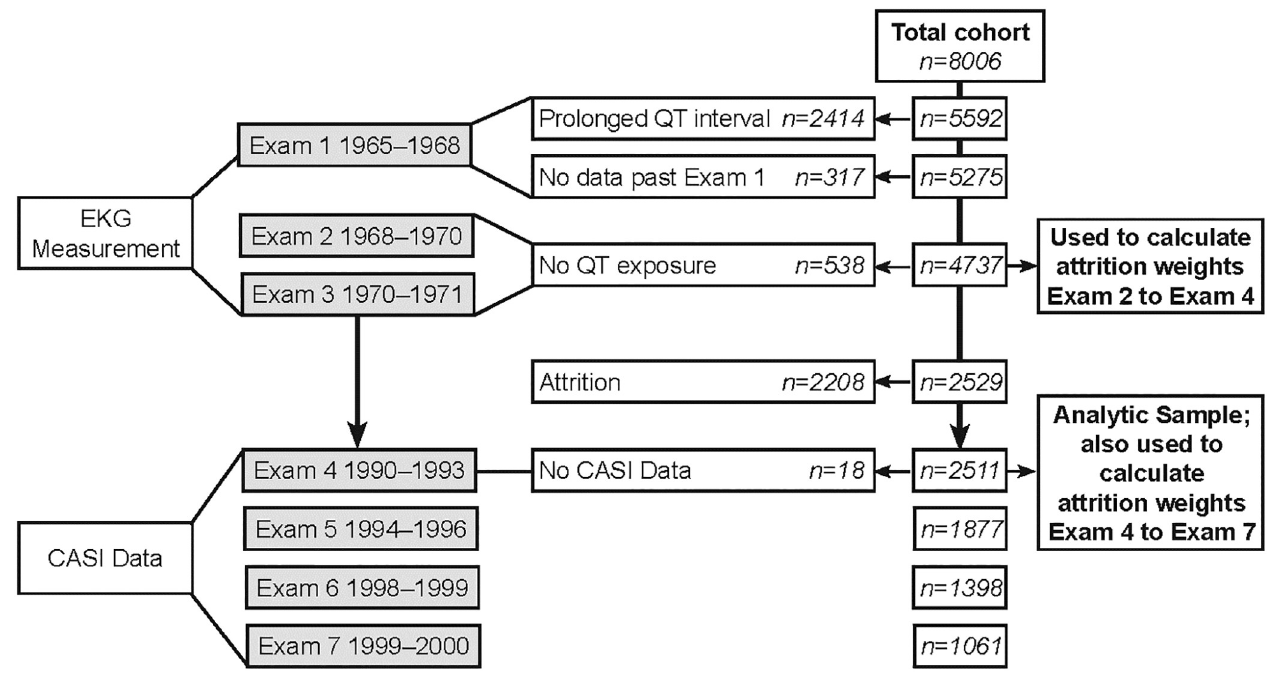
Fig 1. Flowchart of the study participants from the Honolulu-Asia Aging